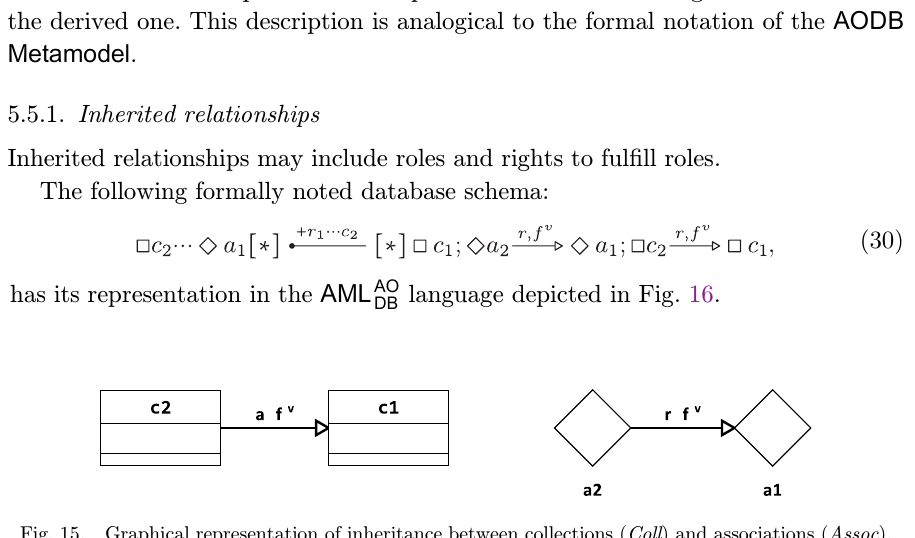
Fig. 15. Graphical representation of inheritance between collections ( Coll ) and associations ( Assoc